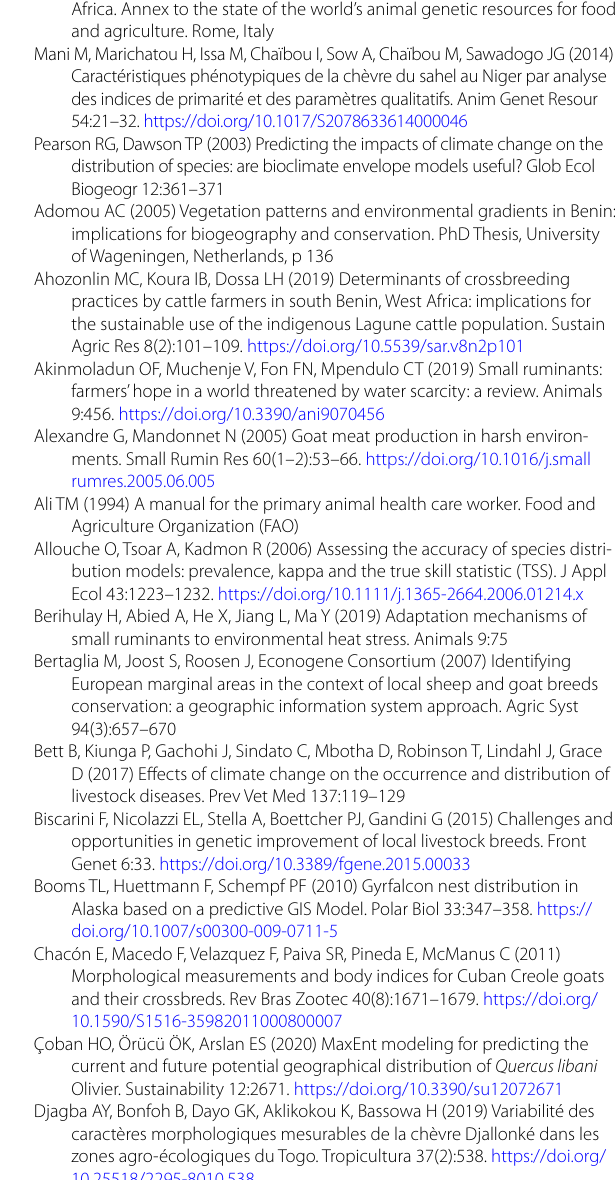
Additional file 2: Table S1. Characteristics of the ten phytogeographic zones of Benin. Table S2. Description of linear body measurements (in centimeters) and qualitative traits taken on 2114 adult female goats in Benin. Table S3. Morphological indices calculated from linear body measurements taken on 2114 adult female goats in Benin. Table S4. Goat types, occurrence numbers, and most discriminating variables. Table S5. Environmental variables used and their description. Table S6. Incidence of vegetation zone, doe’s parity number, and presence or absence of supernumerary teats on birth type. Table S7. Stepwise selection sum- mary. Table S8. Total canonical coefficients for the canonical function, the adjusted canonical correlation, the eigenvalue, and the percentage total variance accounted for . Table S9. Mahalanobis distances between goat subpopulations identified by vegetation zones ( n 2114). Table S10. = Mahalanobis distances between goat subpopulations identified by phytogeographic zones ( n 2114). Table S11. Dynamic of distribution of = suitable habitat for the distribution of goat subpopulations GCZ, GSZ, and SZ under two RCPs scenarios in Benin Table S12. Percentage change of the suitability levels (low, moderate, suitable, high) for the distribution of GCZ, GSZ and SZ goat subpopulations. Table S13. Morphometric charac- teristics of the goat types of